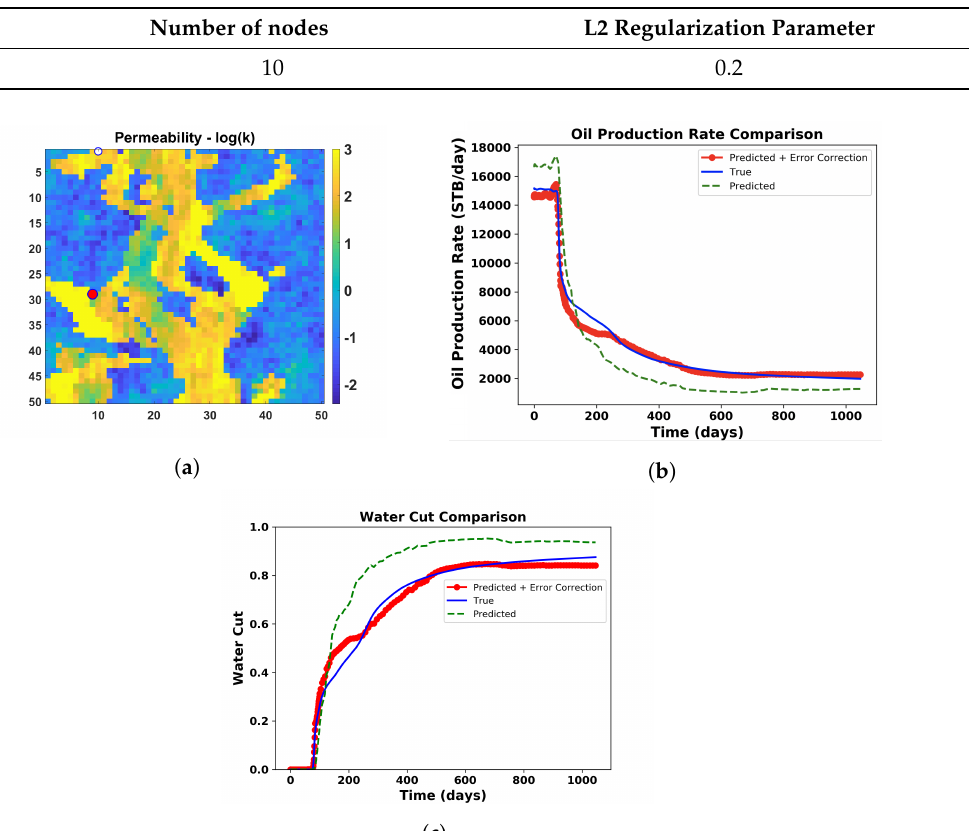
Table 10. Error NN model hyperparameters found through grid search for the heterogeneous model with lower basis dimensions in the first step.